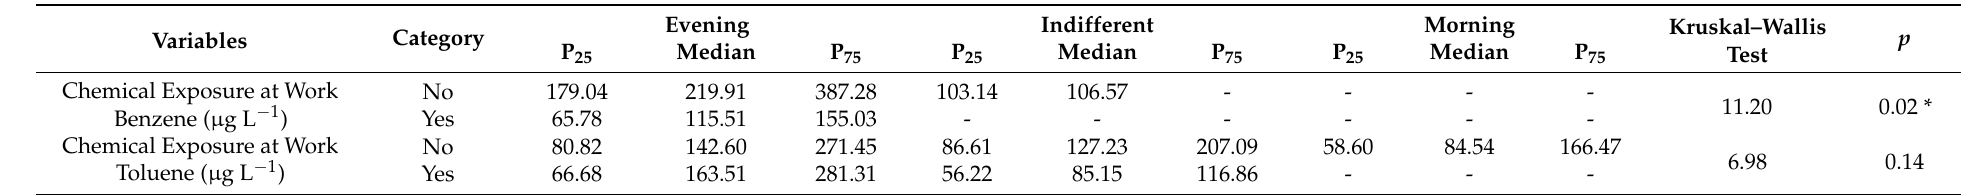
Table 9. Unmetabolized benzene and toluene in urine ( µ g L − 1 ) according to PER3 gene polymorphisms and occupational exposure to